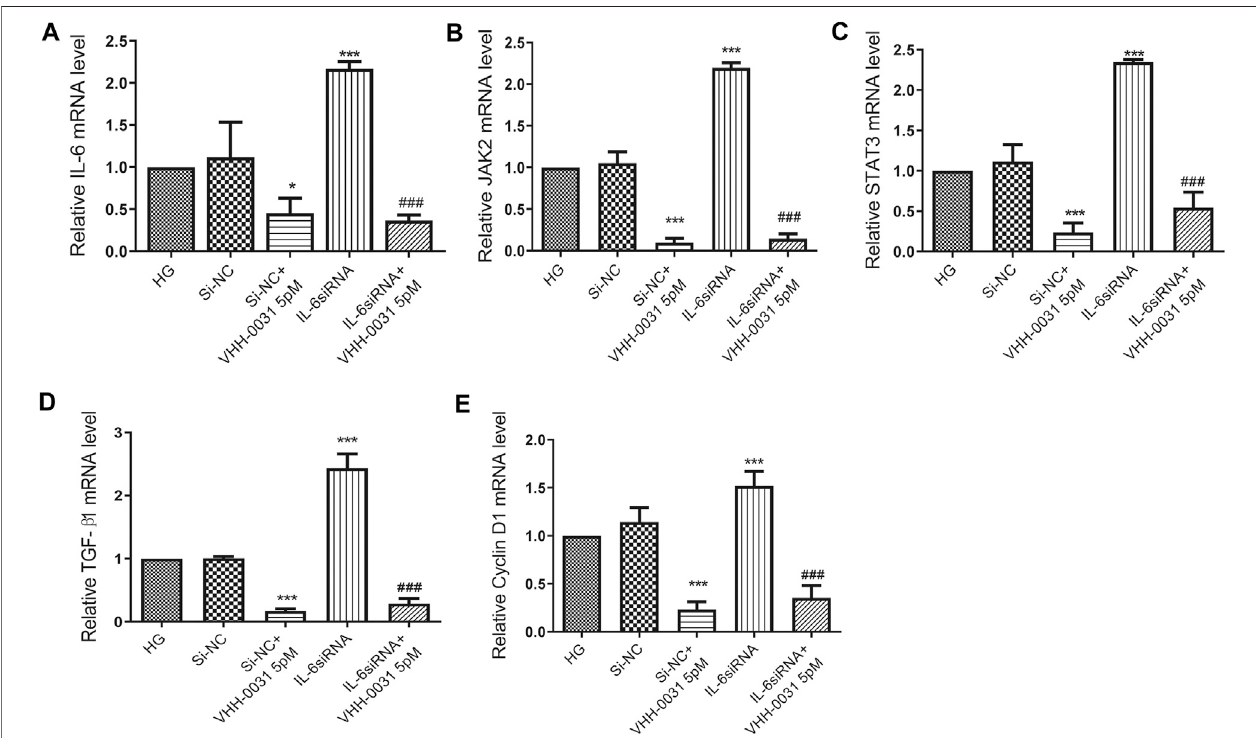
FIGURE 6 | Effect of VHH-0031 suppresses JAK2/STAT3 pathway in high-glucose and IL-6siRNA stimulated mesangial cells. Cells were treated with random sequence IL-6siRNA (Si-NC), or random sequence IL-6siRNA and VHH-0031(Si-NC + VHH-0031 5pM), or IL-6siRNA, or IL-6siRNA and VHH-0031 (IL-6siRNA + VHH- 0031 5 pM) in the presence of high glucose (HG). The mRNA expression level of IL-6 (A) , JAK2 (B) , STAT3 (C) , TGF- β 1 (D) and Cyclin D1 (E) in HBZY-1 cells were detected by qRT-PCR. * p < 0.05, *** p < 0.001 vs HG group, ### p < 0.001 vs IL-6siRNA